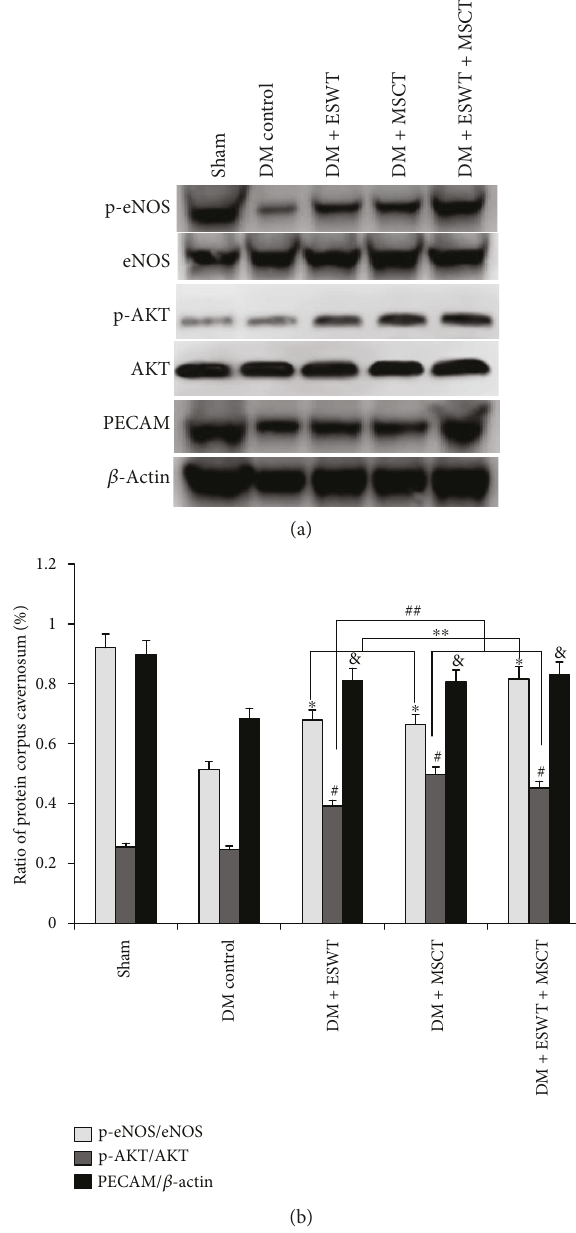
Figure 5: ESWT increases proteins of proliferation, autophagy, and migration. (a) All groups were compared for p-eNOS, eNOS, p- AKT, AKT, and PECAM in the corpus cavernosum using Western blotting. (b) Quantity analysis of Western blotting, including p- eNOS/eNOS, p-AKT/AKT, and PECAM/ β -actin. ∗ P < 0 05 compared with values from the DM control group. ∗∗ P < 0 05 compared with the DM+ESWT and DM +MSCT groups. # P < 0 05 compared with the DM control group. ## P < 0 05 compared with the DM +MSCT and DM +ESWT+ MSCT groups. & P < 0 05 compared with the DM control